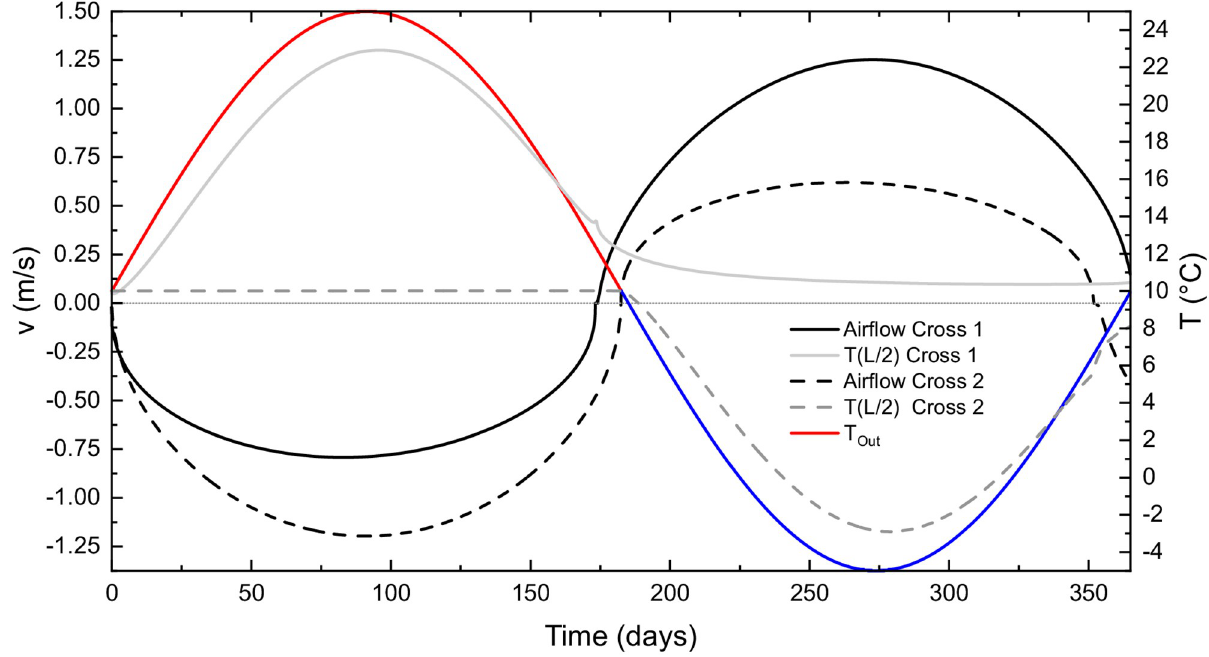
Fig 11. Airflow velocities, external temperature and temperature at L /2 during annual cycle for the two cases with change in pipe diameter (see insert in Fig 12).